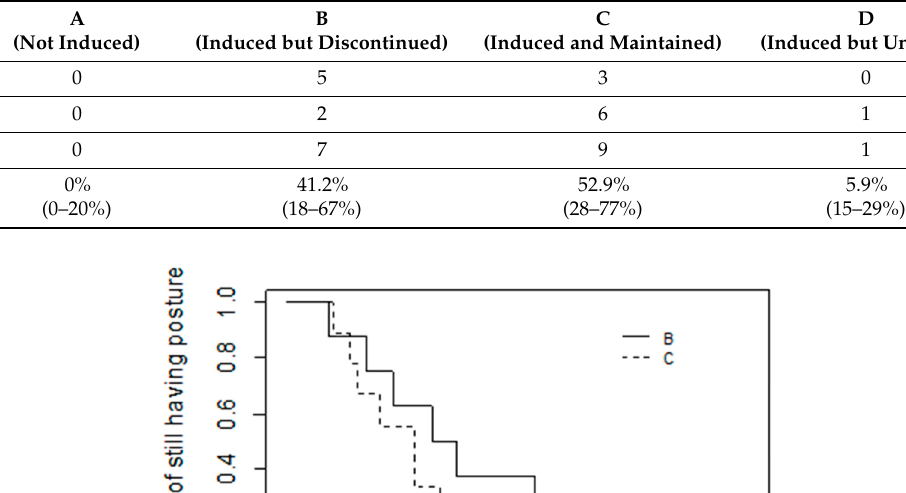
Table 3. Number and percentage of piglets in each induction category for each method of squeeze application, with 95% confidence intervals for the percentage in each category. Category A refers to piglets that were not induced into a less-responsive state; Category B refers to piglets that were induced but had the squeeze discontinued due to high intensity arousals; Category C refers to piglets that were induced and maintained in a less-responsive state for the full 10 min; Category D refers to piglets that were induced but discontinued due to physiological instability.